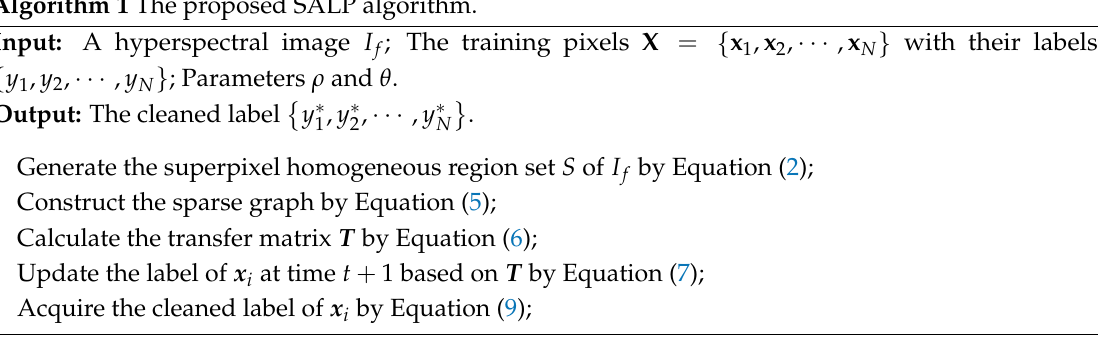
Algorithm 1 The proposed SALP